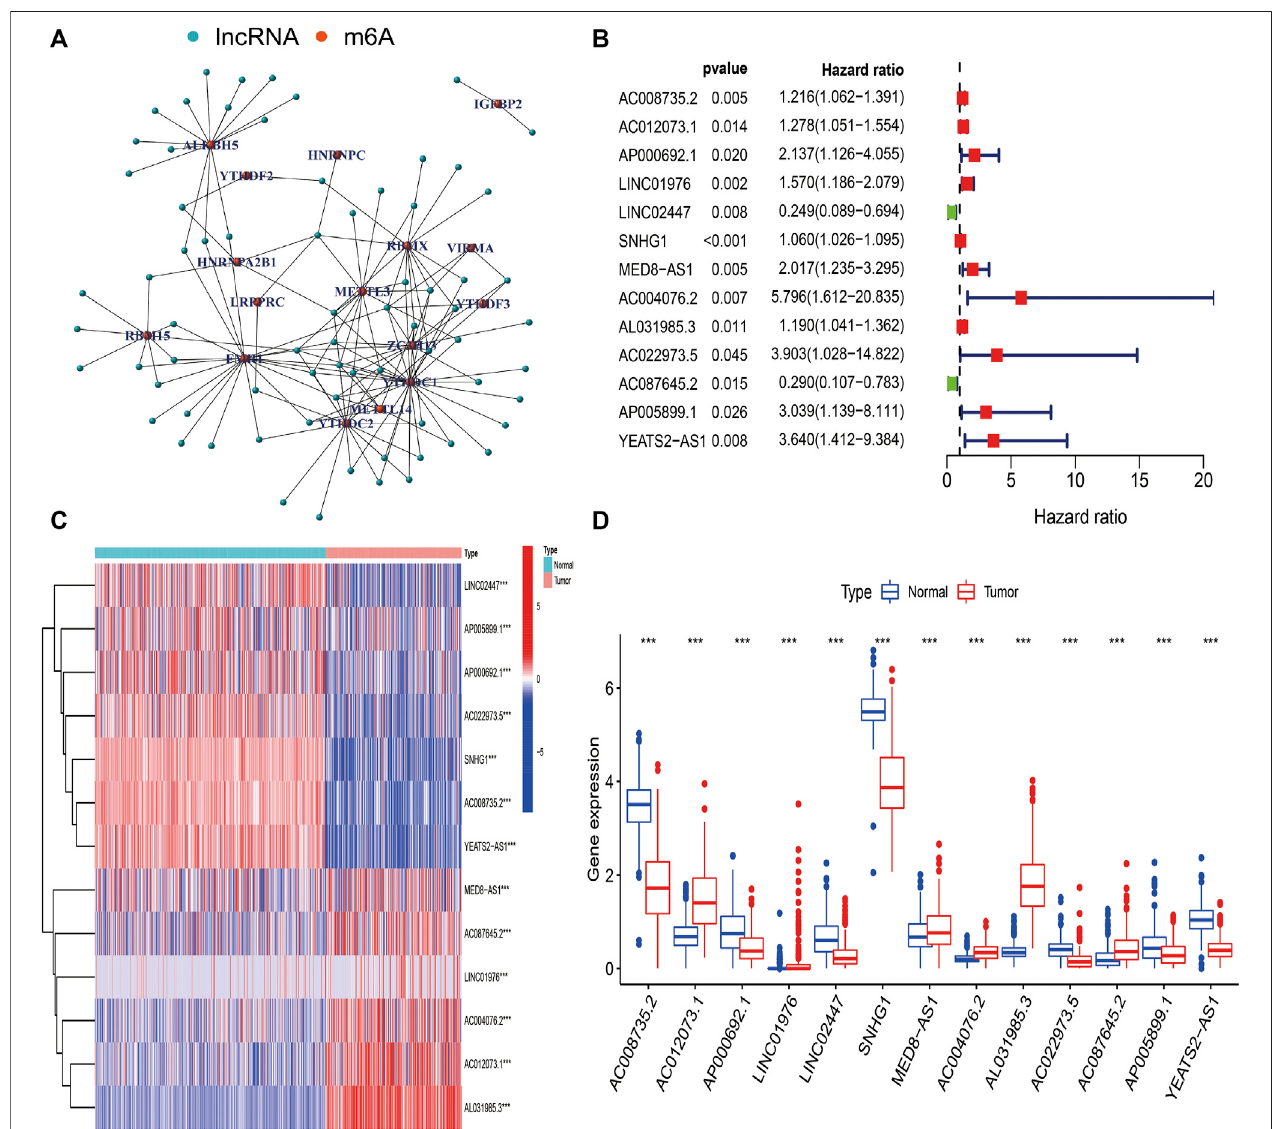
FIGURE2 | Identi fi cation ofm6A-relatedlncRNAsin STS. (A) The network of72m6A-related lncRNAs. (B) The forest plot of13 prognostic m6A-relatedlncRNAs. (C) The heatmap of 13 prognostic m6A-related lncRNAs in both tumor and normal samples. (D) The box plot of 13 prognostic m6A-related lncRNAs in both tumor and normal